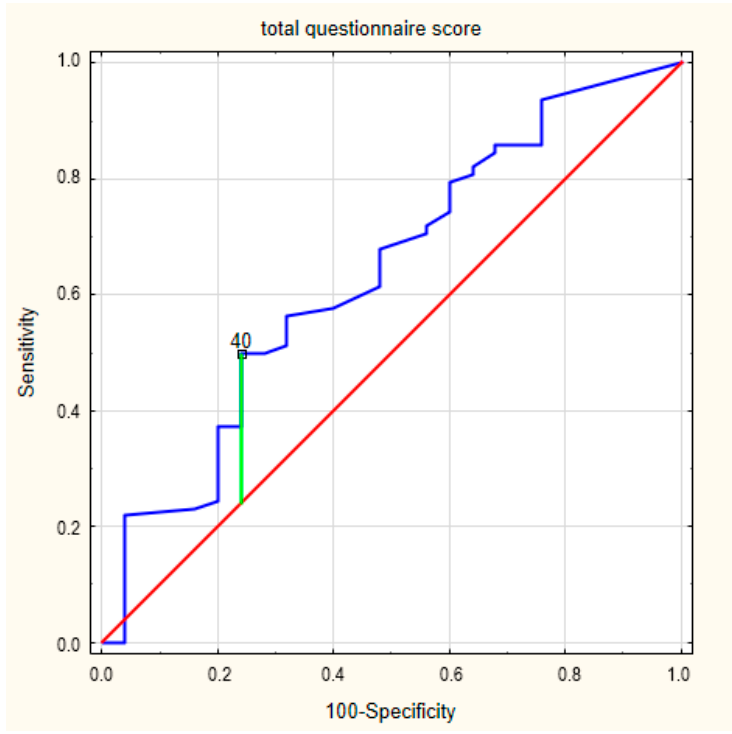
Figure 1. The receiver operating characteristic (ROC) curves for the concerns about an implantable cardioverter defibrillator (ICD) in frailty syndrome.